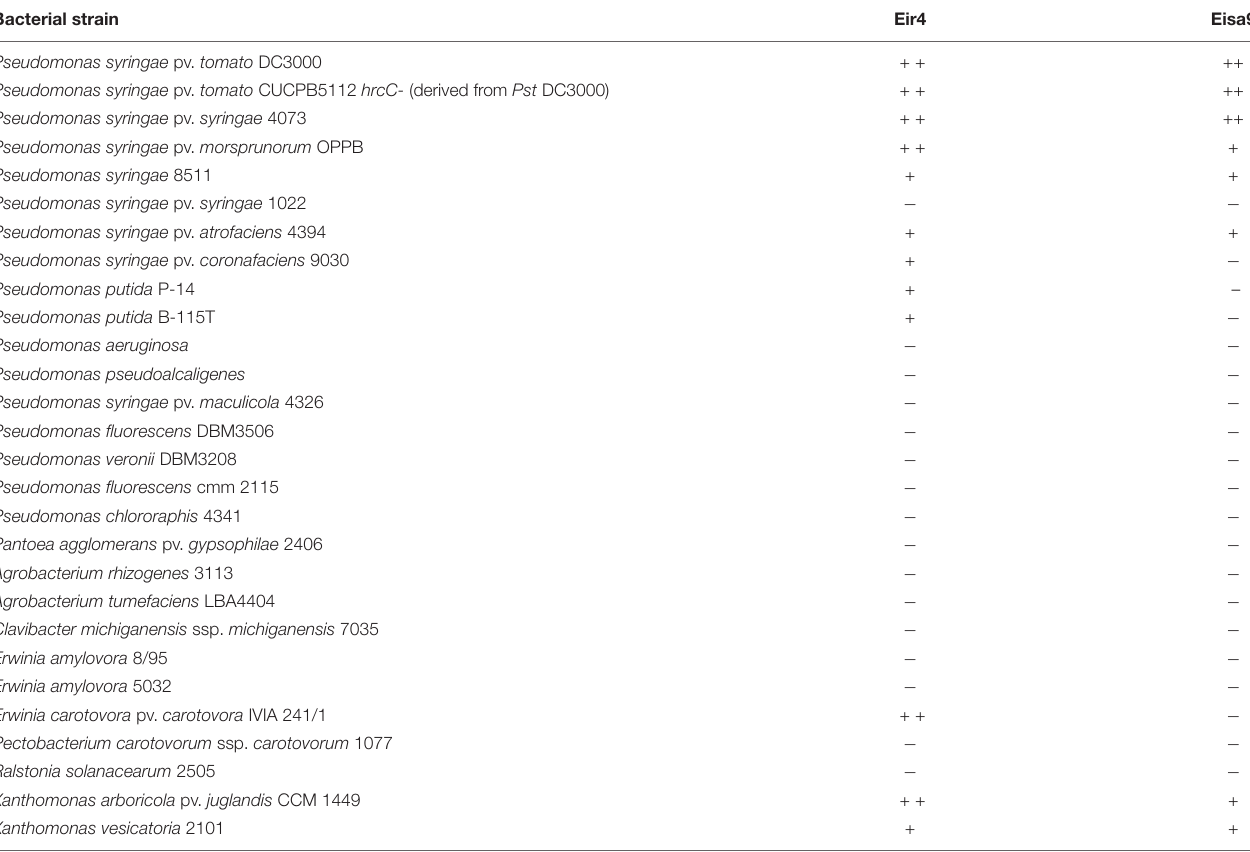
Bacterial strain Eir4 Pseudomonas syringae pv. tomato